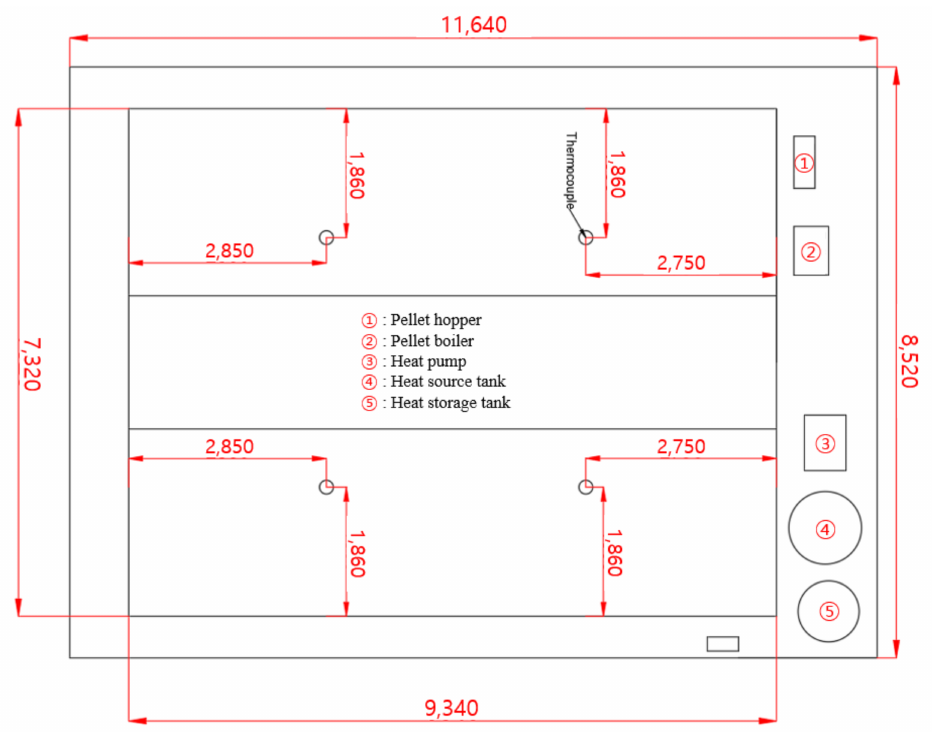
Figure 5. Thermocouple position for temperature data. Table 4. Details of